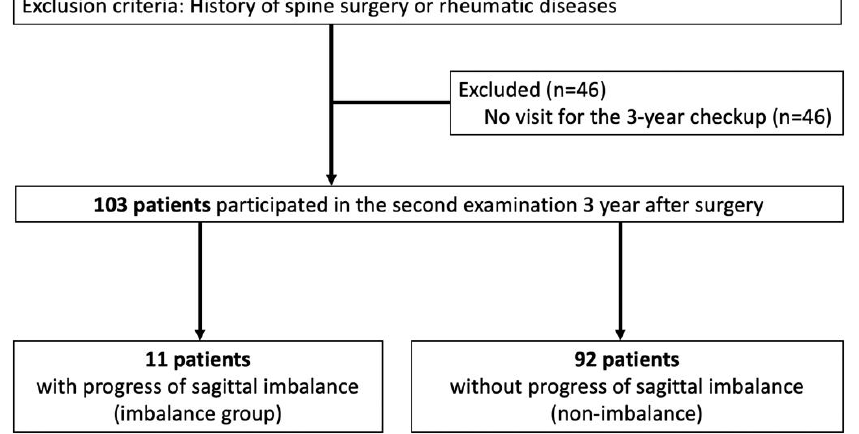
Figure 1. Flowchart describing the selection process of study participants and their assignment to the two